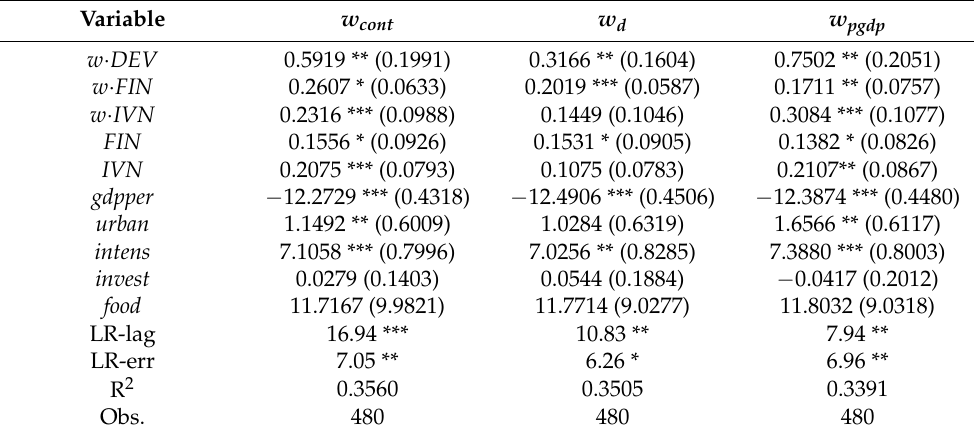
Table 2. Estimated results of the full sample from 2000 to